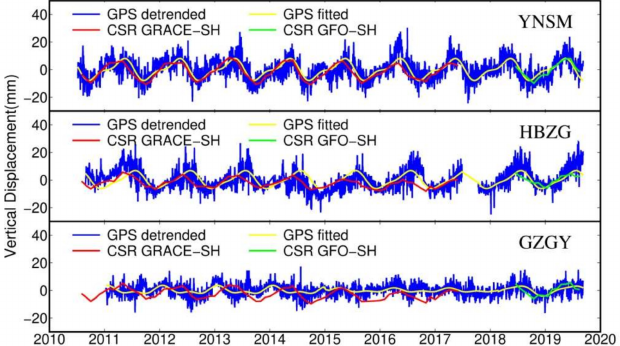
Figure 2. The detrended GPS vertical displacement time series (blue line) and their fitted seasonal time series (yellow line) for three permanent GPS stations (YNSM, HBZG and GZGY) in Southwest China, compared with monthly variations of vertical displacement derived from Center for Space Research (CSR) RL06 Gravity Recovery and Climate Experiment (GRACE) Spherical Harmonic (SH) solutions (CSR GRACE-SH, red line) and CSR RL06 GRACE Follow-On (GFO) SH solutions (CSR GFO-SH, green line) with AOD1B atmosphere combined with ocean (GAC) contributions restored.